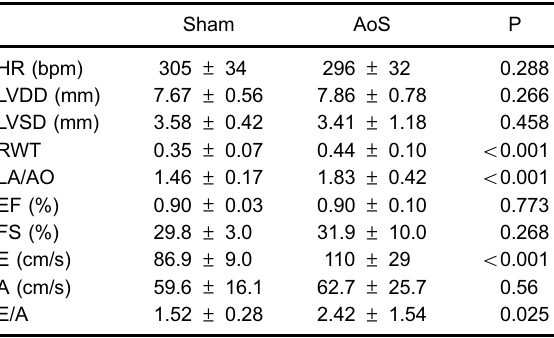
Table 2. Functional and structural study results of